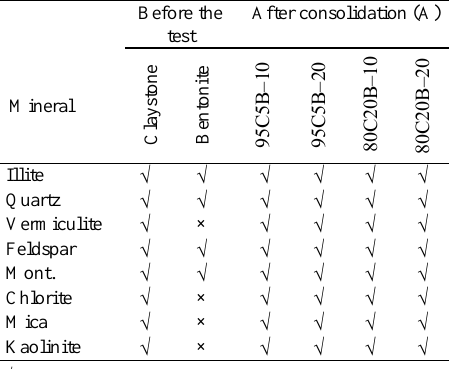
Table 4. Sample’s mineralogy before and after the